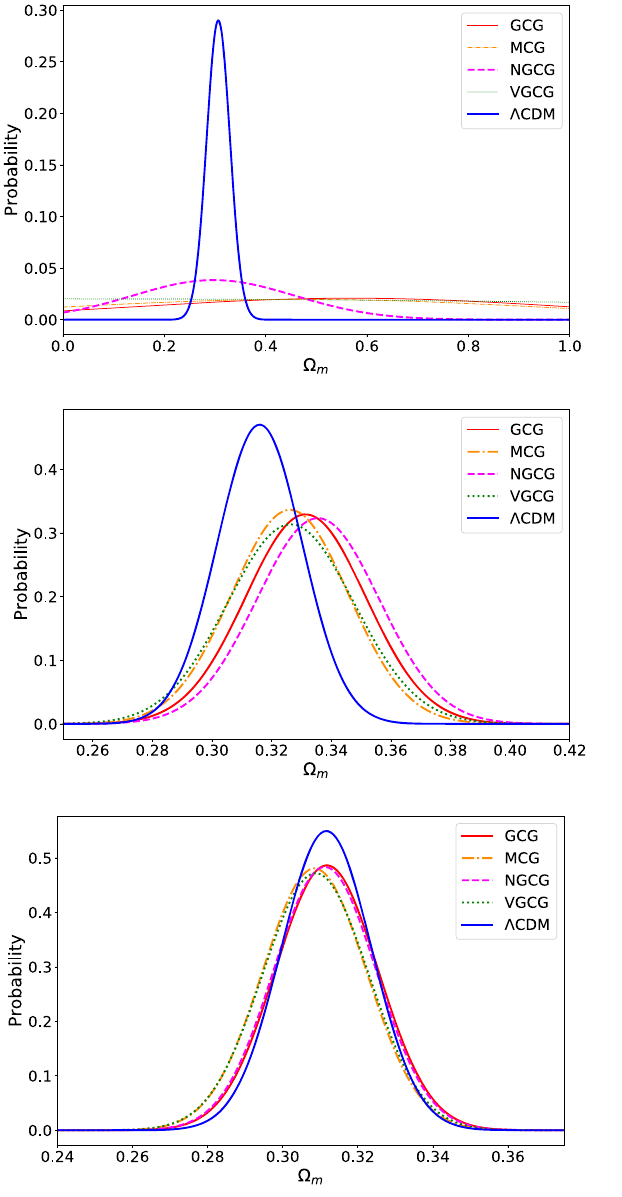
Fig. 6 The posterior distributions of Ω m for the GCG, MCG, NGCG, VGCG and Λ CDM models, with the standard candles, standard rulers and combination data from the top to the bottom. We adopt the posterior distributions of Ω m from Table 2